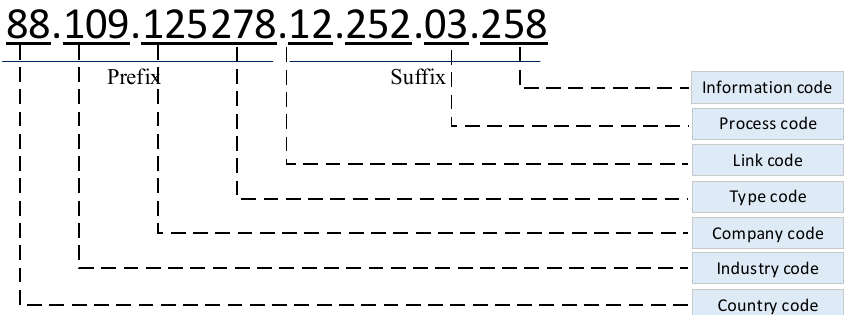
Figure 4. Coding diagram. Figure 4. Coding